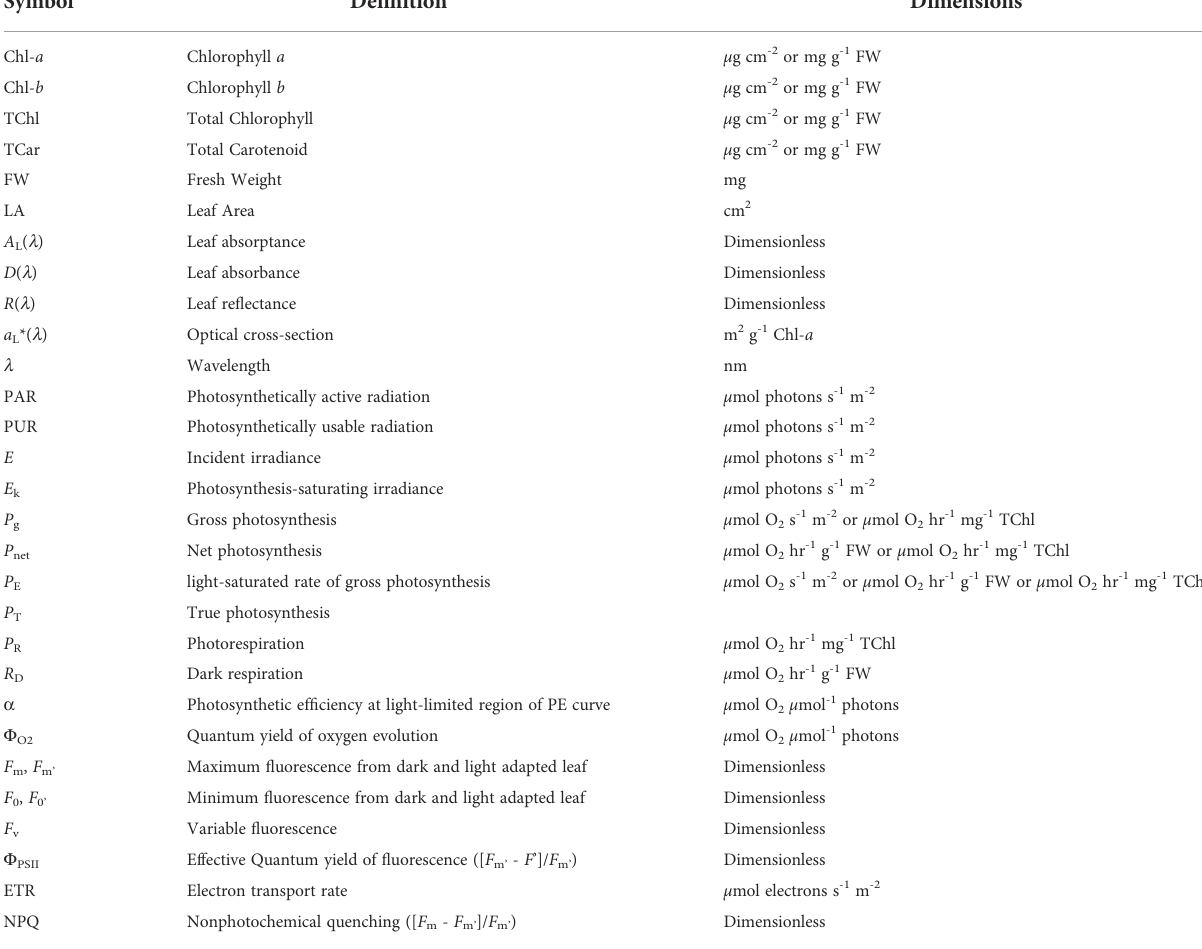
Parenthetic notation ( l ) denotes wavelength dependence of the